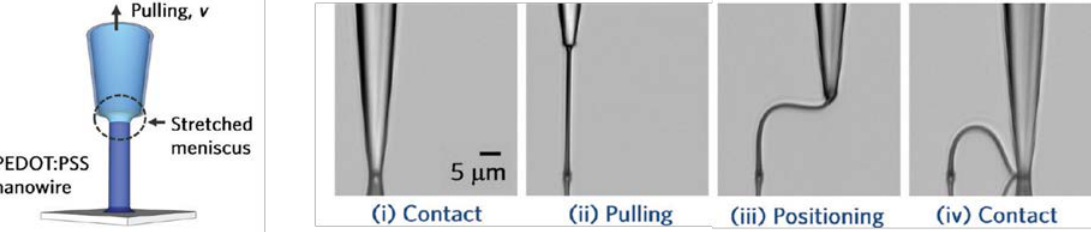
Figure 3. drawing of conductive PEDOT:PSS nanowires. Adapted with permission from [65]. Copyright 2012 American Chemical Society.